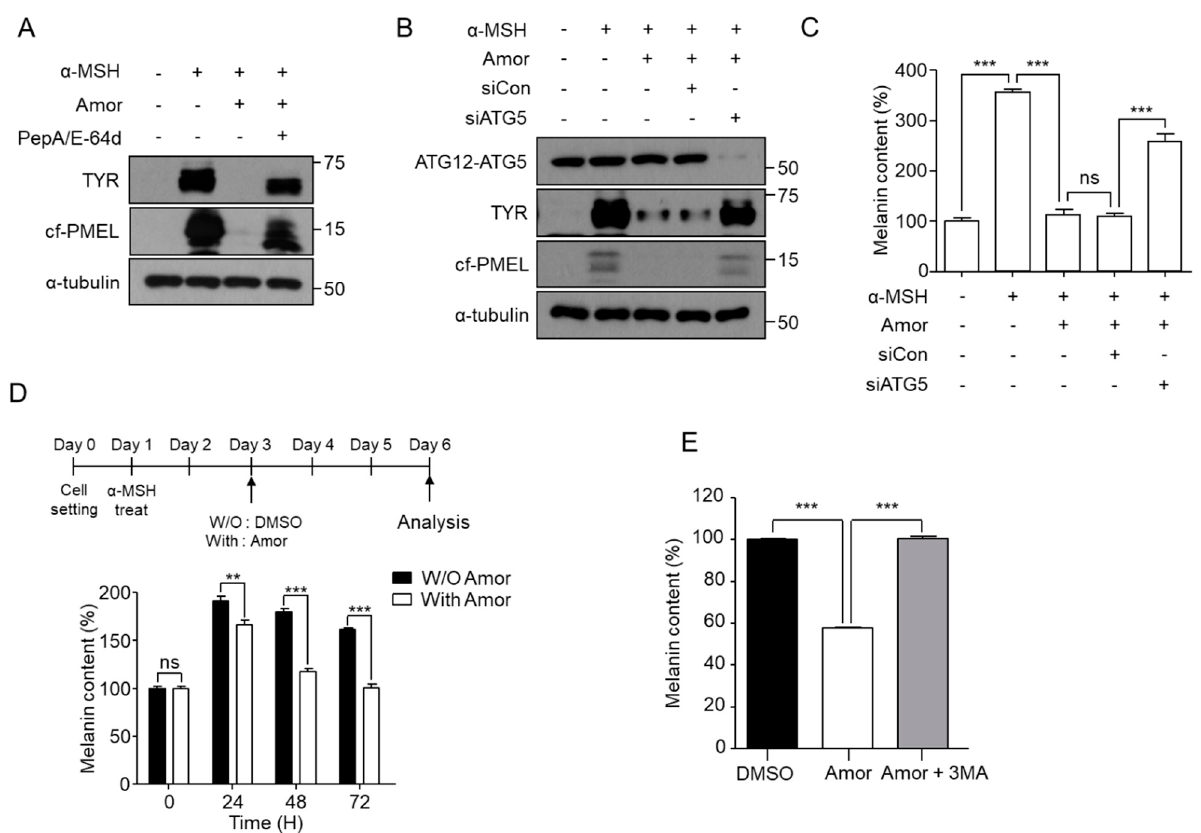
Figure 4. Amorphigenin induces autophagy-mediated depigmentation. ( A ) Following treatment with 1 μ M α -MSH with 0.012 ppm of amorphigenin (Amor) for 24 h, the cells were further treated with PepA1/E-64d (10 μ g/mL each) for an additional 24 h. Next, the indicated protein levels were analyzed using Western blotting. ( B , C ) siRNA was transfected into B16F10 cells, and after 24 h, the transfected cells were treated with 1 μ M α -MSH in the presence or absence of 0.012 ppm amorphi- genin for 48 h. Then, the indicated protein levels ( B ) and melanin content ( C ) were measured. After experiments were performed according to the schematic, the melanin content was measured ( D , E ). Data were obtained from at least three independent experiments, and the values represent the mean ± SEM. Note: ns, not significant; ** p < 0.01 and *** p < 0.001 according to t -tests.